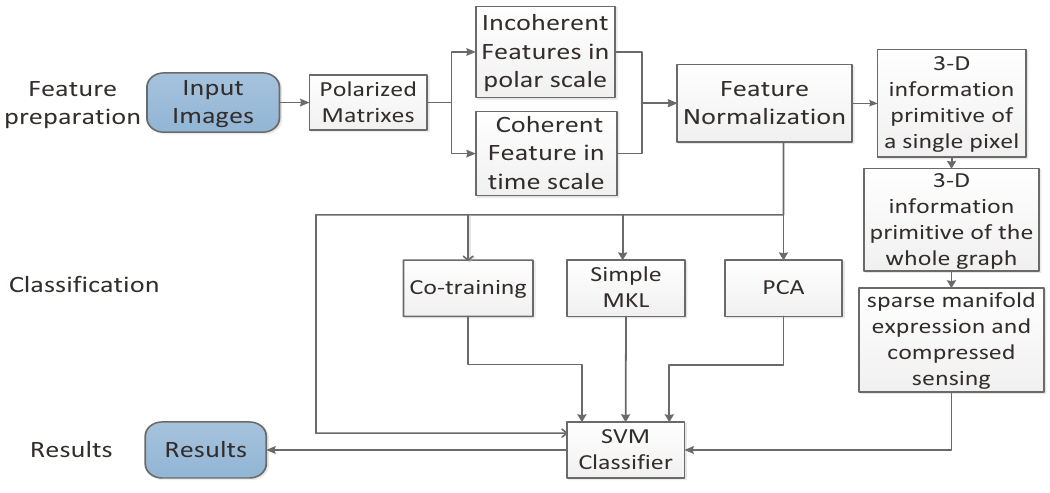
Figure 3. Framework of the validation